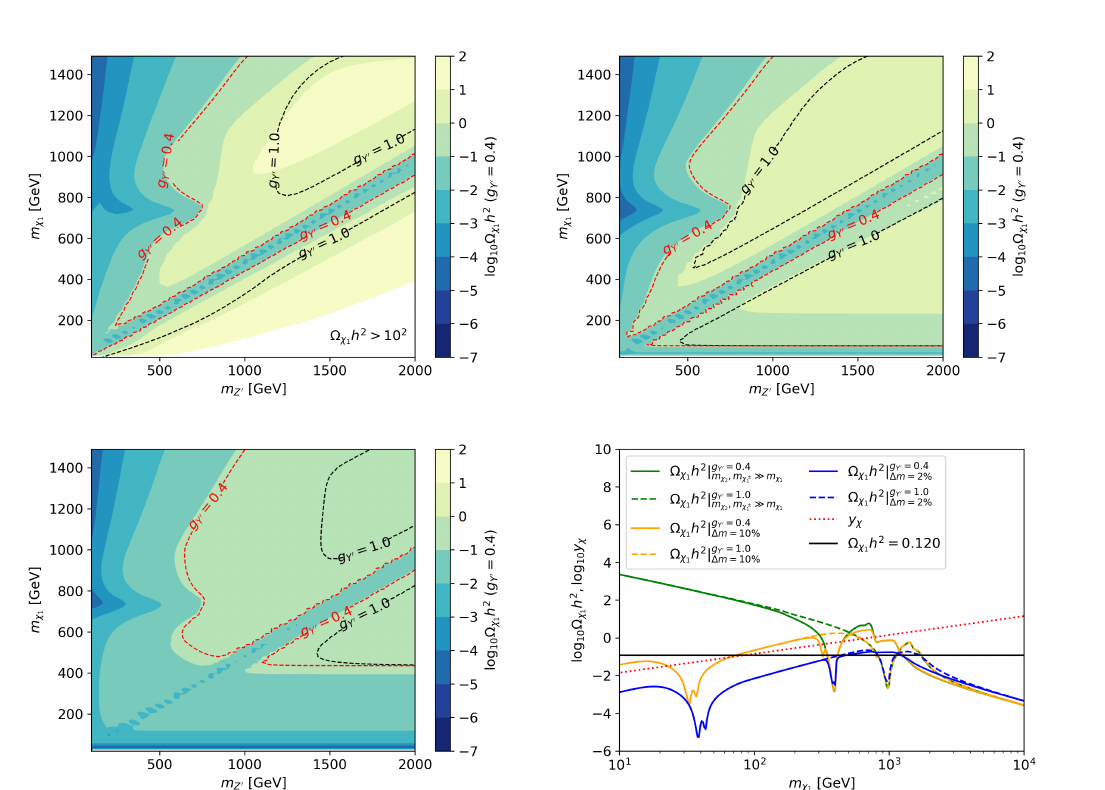
= 0.4 as a function of m Figure 5: The relic density after freeze-out for g and Y (cid:48) Z (cid:48) = 1500 GeV, y = 1.5 y m χ for m and θ χ . Results are presented as a function of m χ S 1 1 m for y φ (cid:29) y χ (no coannihilation, top left), ∆ m = 10% (top right), ∆ m = 2% Z (cid:48) = 1000 and g = 0.4,1.0 for these (bottom left), and as a function of m χ for v S Y (cid:48) 1 scenarios (bottom right). In the 2D plots the red dashed line shows the contour with = 0.4, whereas the black dashed line shows the same the correct relic density for g Y (cid:48) = 1.0 for contour for g Y (cid:48)